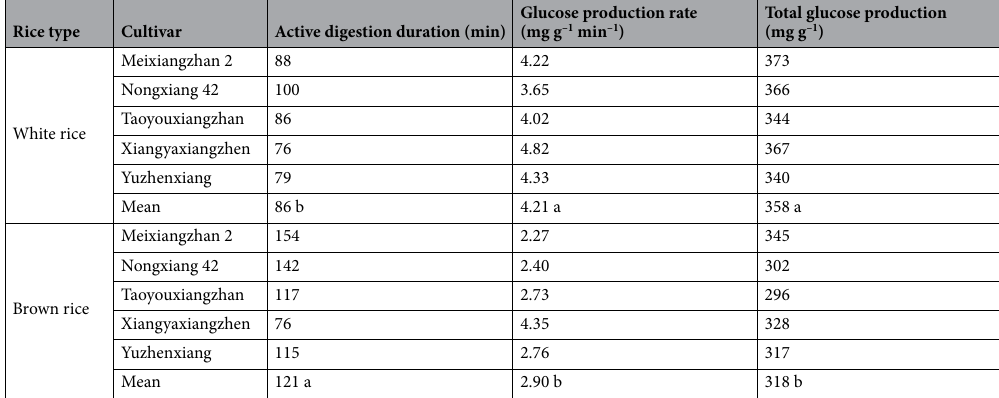
Table 3. Starch digestion properties of cooked white and brown rice of five cultivars. Means within a column sharing different letters are significantly different from each other at the 0.05 probability